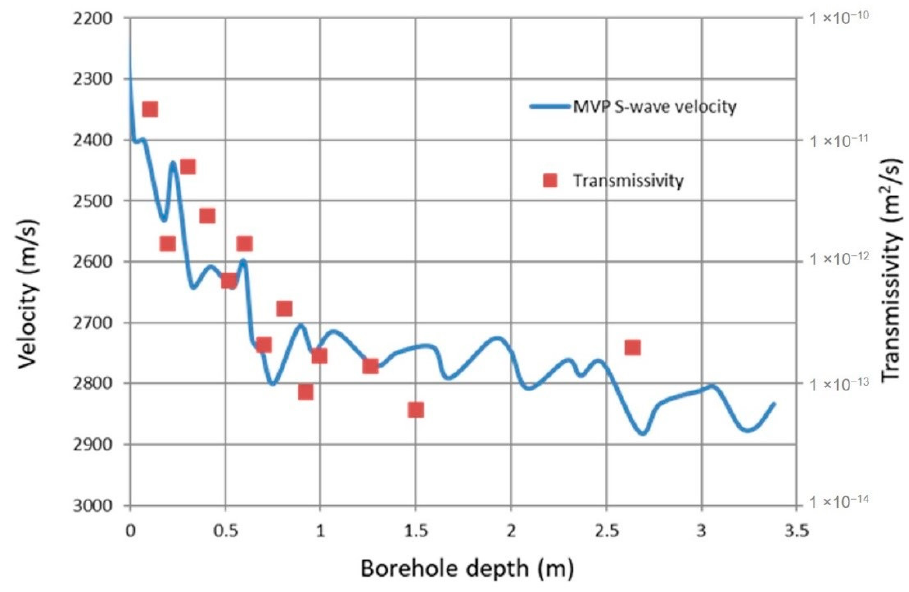
Figure 11. S-Wave velocity and transmissivity around TSX tunnel (adapted from Chandler et al. [42]).